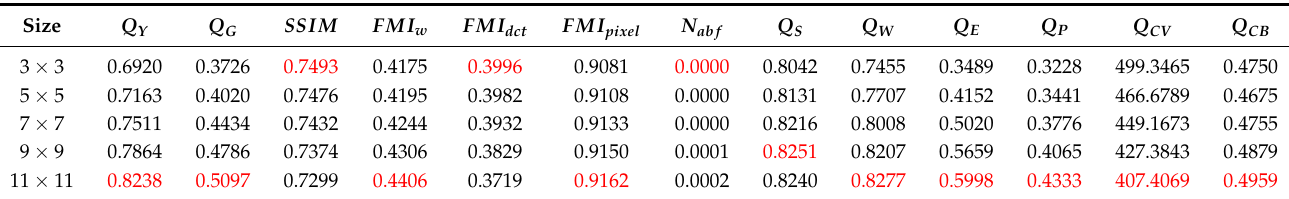
Table 2. The effect of filter